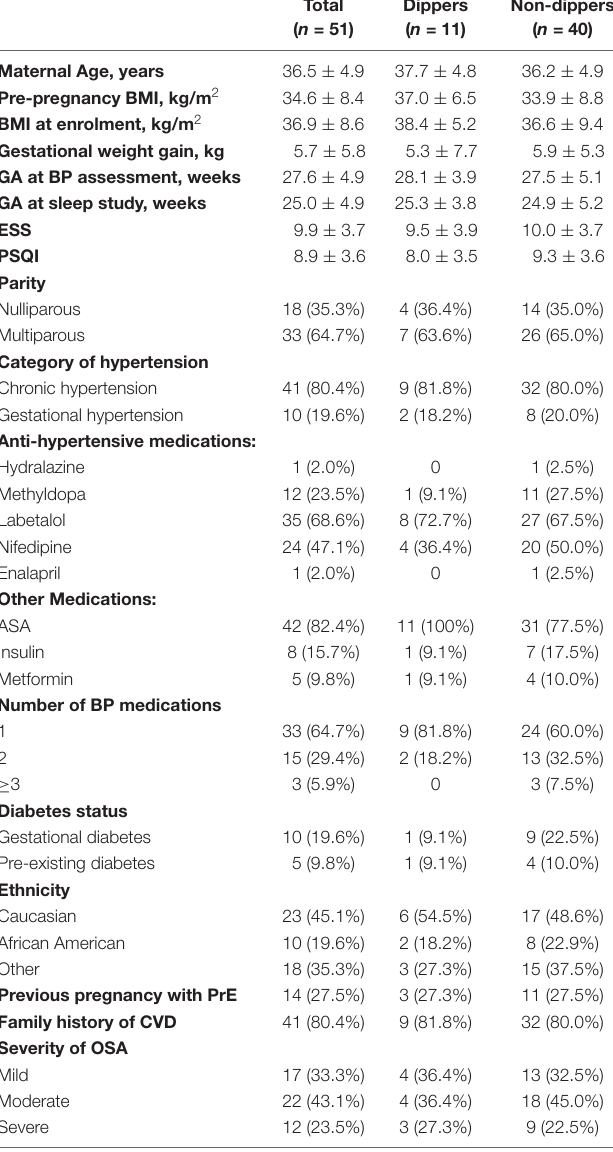
TABLE 1 | Patient characteristics stratified by blood pressure dipping status. TABLE 2 | Polysomnography characteristics of participants stratified by blood pressure dipping